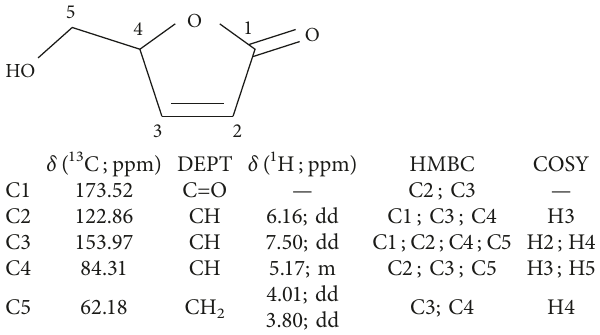
Figure 1: 13 C NMR spectrum of the Helleborus lividus subsp. corsicus dichloromethane leaf extract. Table 1: Structure and NMR data of 5-hydroxymethyl-2(5H)-